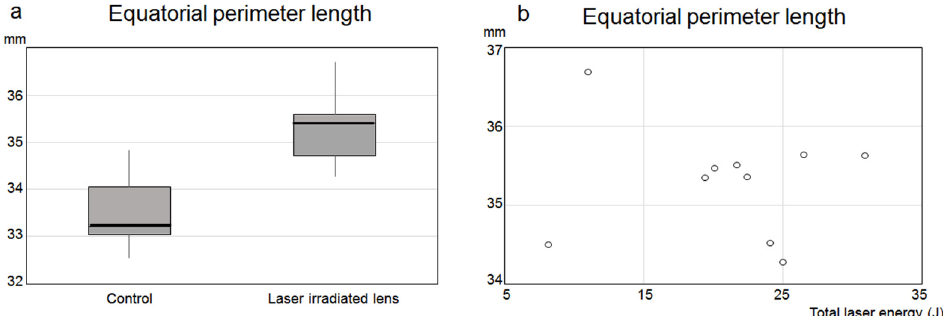
Figure 7. Although the laser irradiation caused significantly longer average equatorial perimeter, there was no correlation with the amount of laser irradiation energy. ( a ) Box-plot diagram showing mean values of equatorial perimeter length in control lens and laser-irradiated lens. Boxes, interquartile range (difference between upper 75% and lower 25% quartiles); thick black lines, median; whiskers, highest and lowest values that were not outliers or extreme values. There was significant difference between these two groups ( p = 0.001 < 0.05). ( b ) No correlation was found between amount of laser irradiation energy and equatorial perimeter of laser-irradiated lens ( p = 0.899 > 0.05).